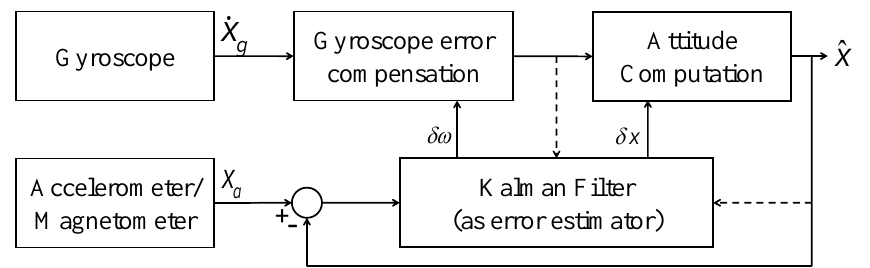
Figure 5. Complementary Kalman Filter.